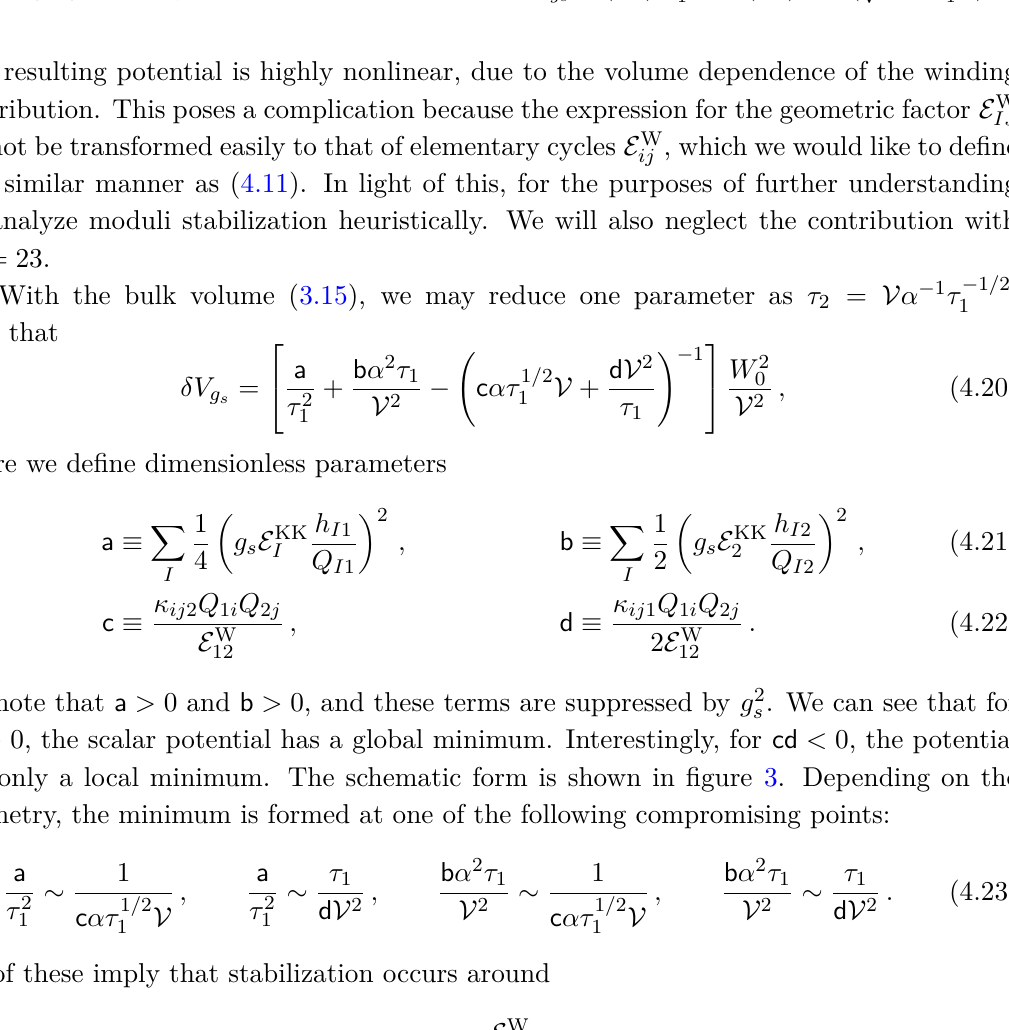
Figure 3 . Schematic form of the one-loop potential. The left and right panels correspond to the cases cd > 0 and cd < 0 , respectively; within these, the orange curves correspond to d > 0 while the blue curves correspond to d < 0 . When the signs are the same we have a global minimum; for opposing signs we only have a local minimum. We use δV g